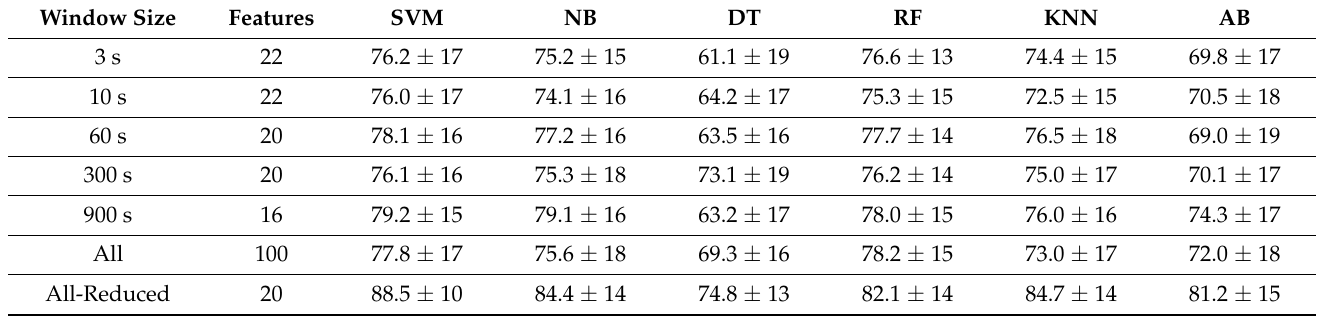
Table 3. Classification of PD vs. HE accuracy values using document-of-words feature engineering. Window